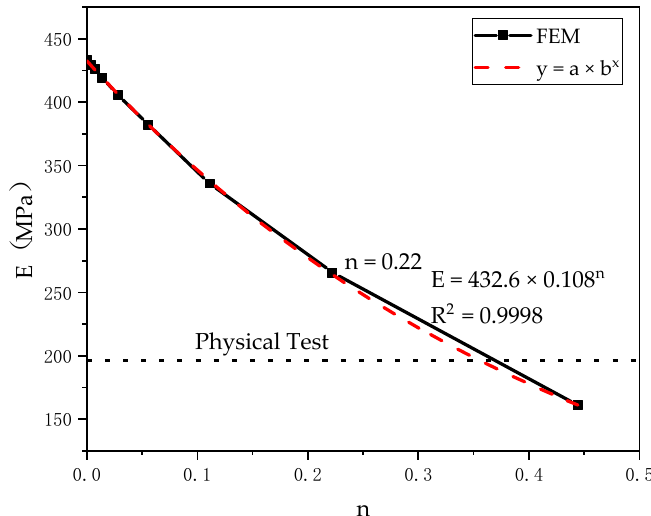
Figure 13. Effect of stiffness reduction coefficient n on equivalent elastic modulus.